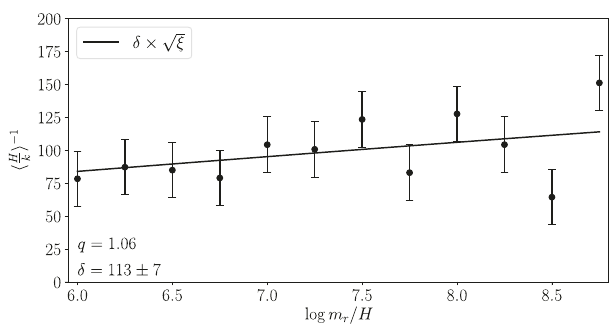
Fig. 4 Evolution of the axion number density. The inverse expectation value 〈 H / k 〉 − 1 is computed using the instantaneous axion spectrum F ( k / H ) by numerically integrating the spectrum to k = H ¼ x max ¼ 50 and then analytically integrating the power law distribution F ( x ) ∝ x − q from x max to the UV cut-off at k = H (cid:2) e log (cid:5) for log (cid:5) (cid:6) 65. The data are illustrated along with their 68% uncertainties. For q > 1 the expectation value does not strongly depend on the UV cut off but is instead a function of the effective ffiffiffi p ξ IR cut-off, which is set by ξ such that h H = K i (cid:3) 1 ¼ δ for some parameter δ , which we determine by fi tting this model to the numerical data as illustrated here. Smaller values of δ correspond to larger axion number densities and thus large axion DM densities. Here, we illustrate the result for the maximum allowed q of 1.06, which leads to the smallest δ consistent with our simulation